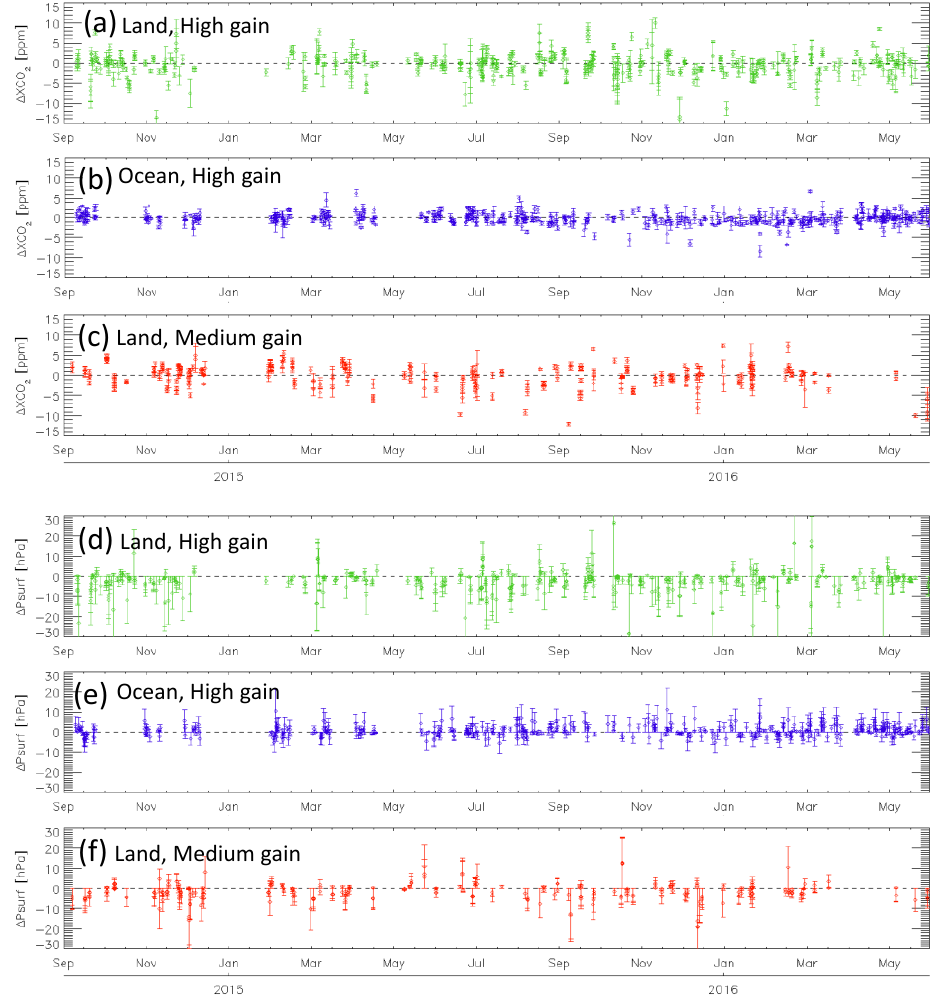
Figure 8. The upper three panels show the time series of ∆XCO 2 ( a ) over land with high gain; ( b ) over ocean with high gain and ( c ) over land with medium gain. The lower panels ( d – f ) show the time series of ∆P surf with the same conditions as the above panels. The error bars indicate the standard deviation of ∆XCO 2 and ∆P surf within GOSAT IFOV.